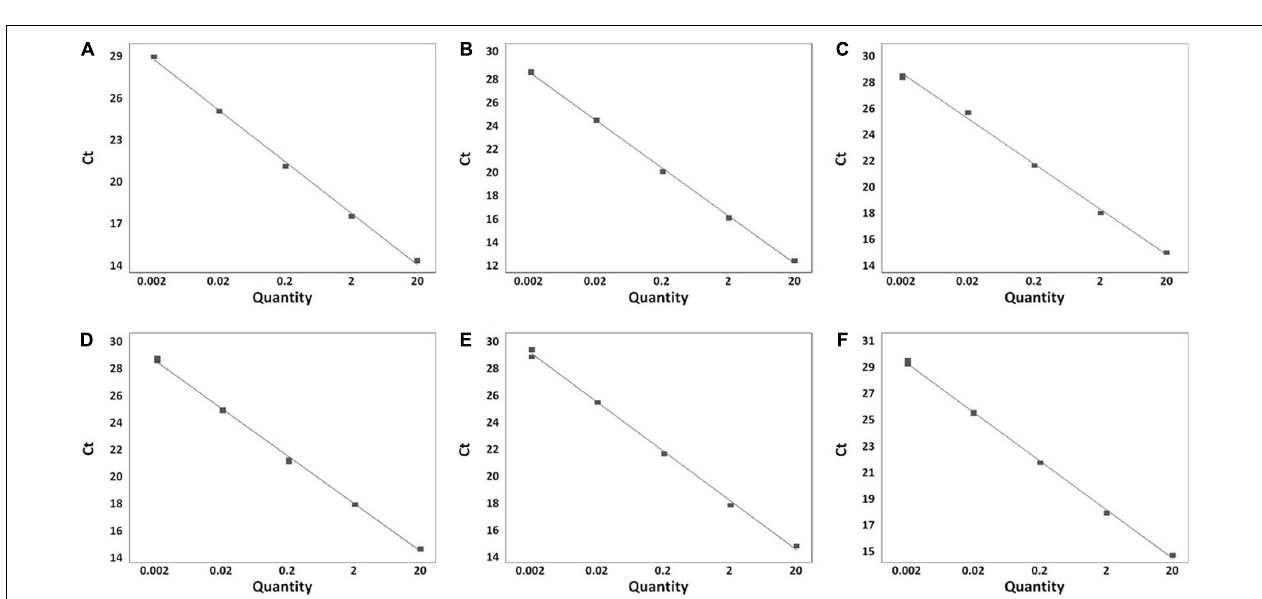
FIGURE 3 | The specificity of serovar-specific primers. (A) Specificity of Bareilly primer pair, amplification curve: Bareilly MFDS 1007637; (B) Specificity of Enteritidis primer pair, amplification curve: Enteritidis MFDS 1010897; (C) I 4,[5],12:i:- primer pair, amplification curve: MFDS 1004858; (D) Specificity of Montevideo specific primer pair, amplification curve: CCARM 8189; (E) Specificity of Typhi primer pair, amplification curve: ATCC 33459; (F) Specificity of Typhimurium primer pair, amplification curve: ATCC 19585. (cid:49) Rn value means Rn (fluorescent signal from SYBR Green) value of an experimental response minus the Rn value of the baseline signal.